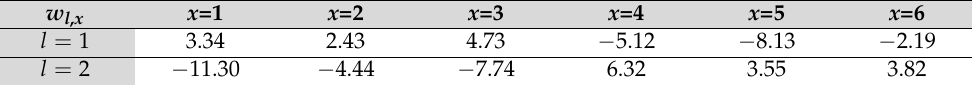
Table 6. Final weight values of the output layer.